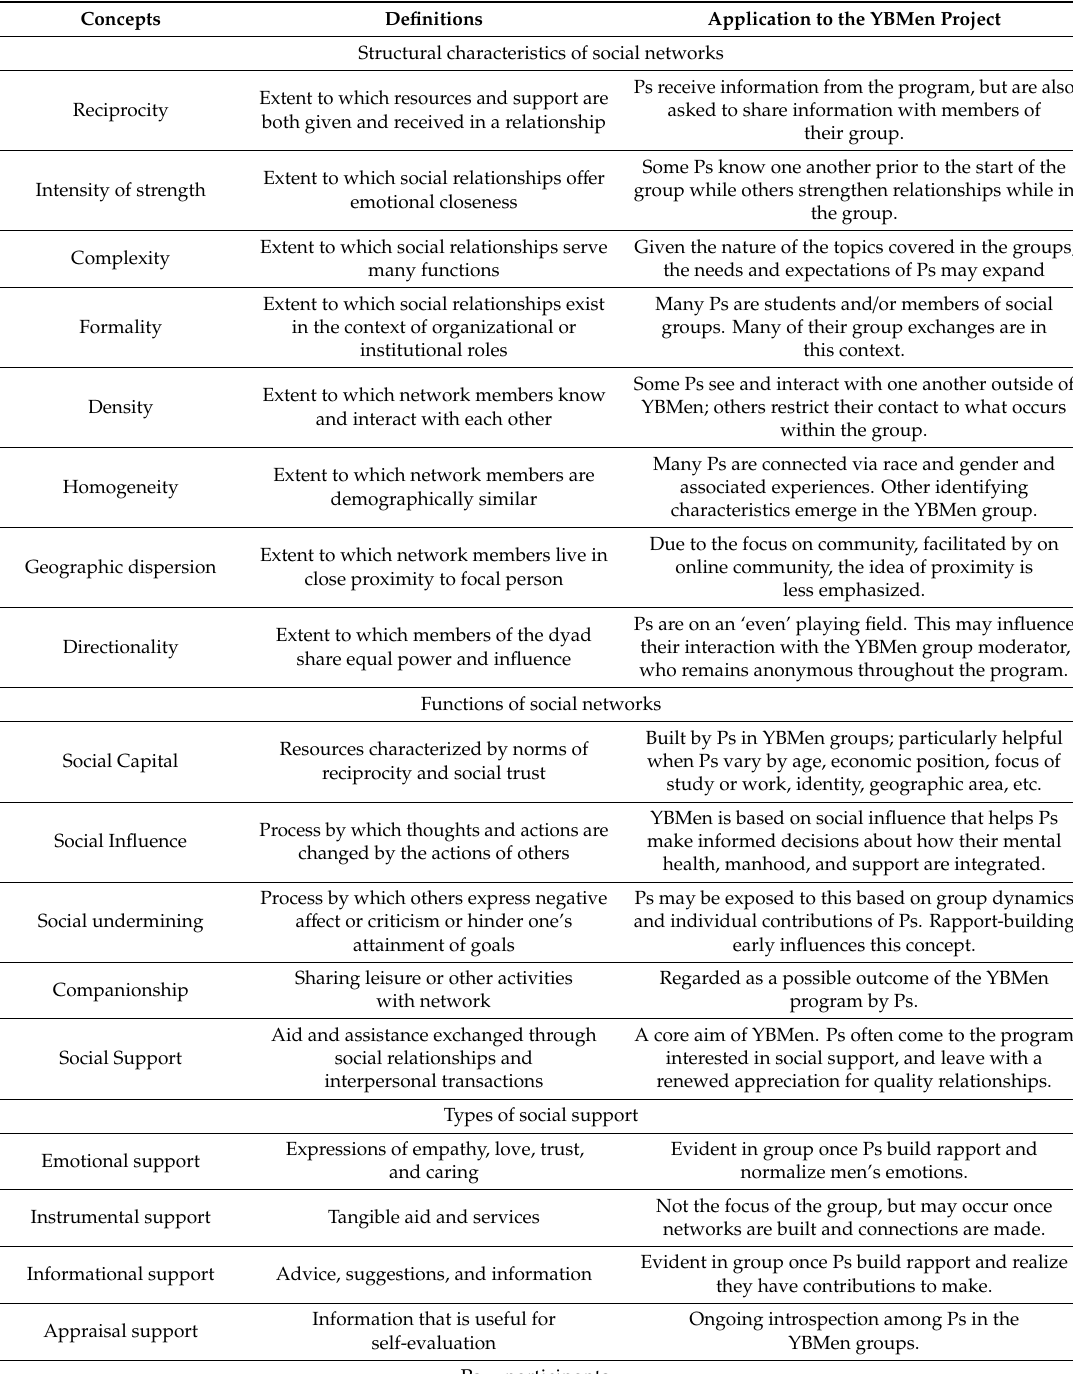
Table 2. Theories of social networks and social support (SNSS) and how they are operationalized in the YBMen